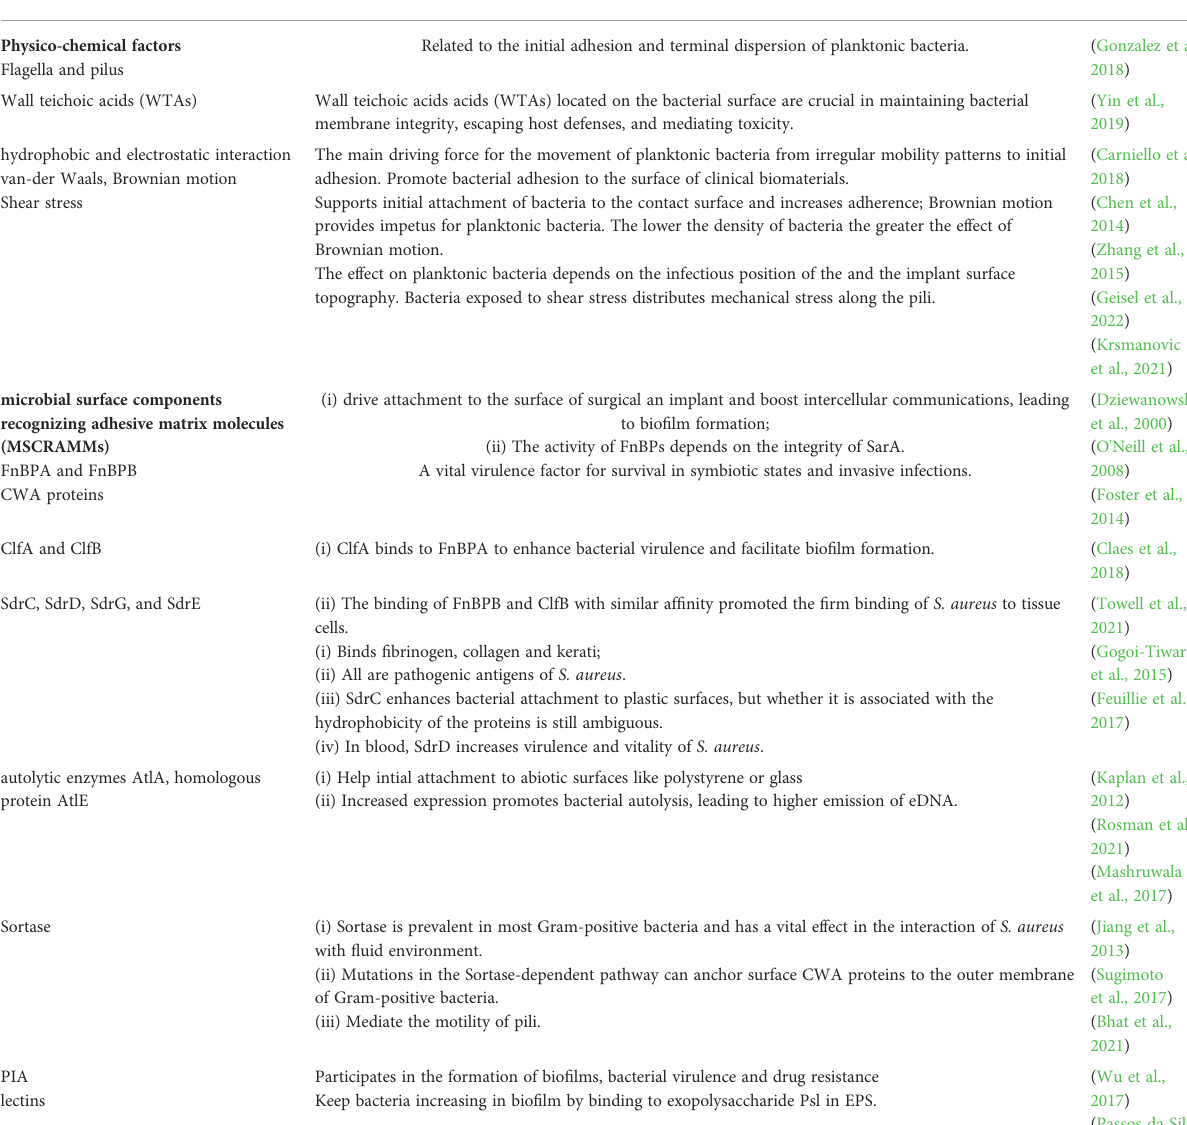
TABLE 1 The main planktonic adhesion regulatory factors. Planktonic adhesion-related factors